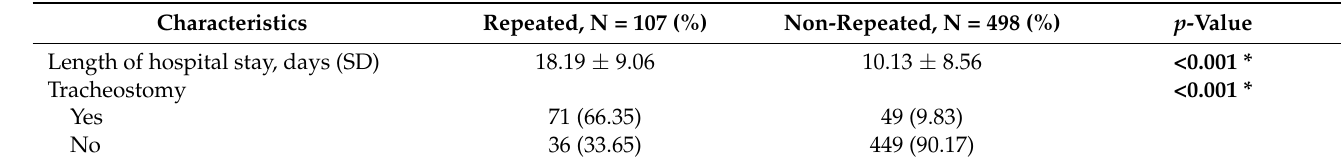
Table 3. Hospital stay lengths and tracheostomy statuses concerning 107 patients who required repeat I&D and 498 patients who did